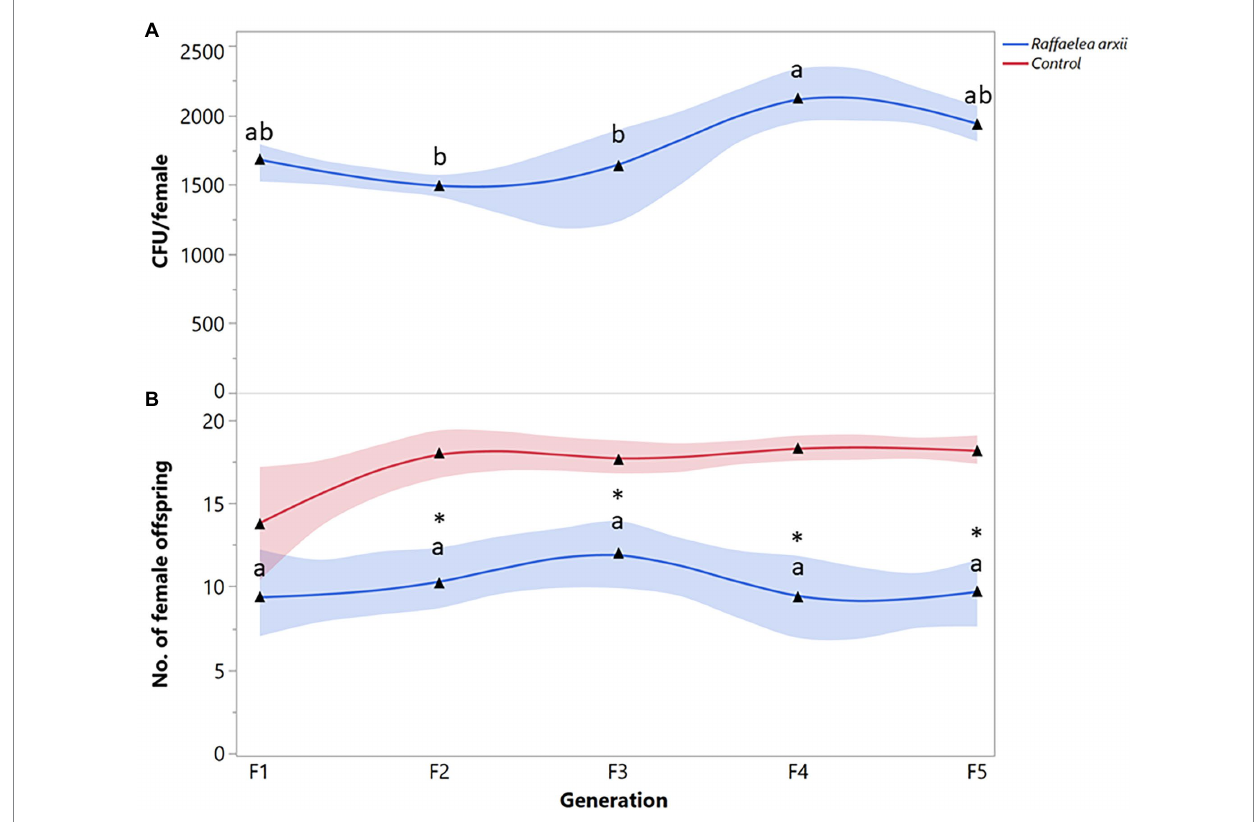
FIGURE 3 Xyleborus bispinatus performance with a single mutualistic fungus ( Raffaelea arxii ). (A) Mean number of CFUs ( ▲ ) recovered from single female offspring per generation and (B) Mean number of female offspring ( ▲ ) produced by single female founder per generation. Same letters within the same color are not significantly different (Tukey HSD, α = 0.05). Asterisks show significant differences in female offspring between fungal symbiont and control within generation (Kruskall-Wallis, α =